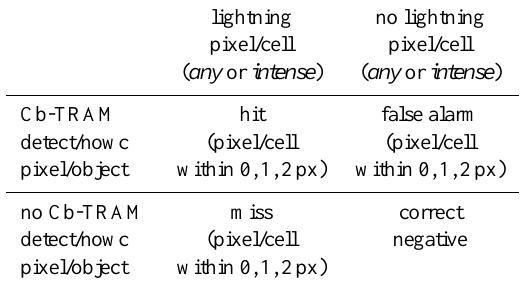
Table 1. Contingency table for the comparison of LINET lightning and Cb-TRAM detections and nowcasts of mature thunderstorms on a pixel/object